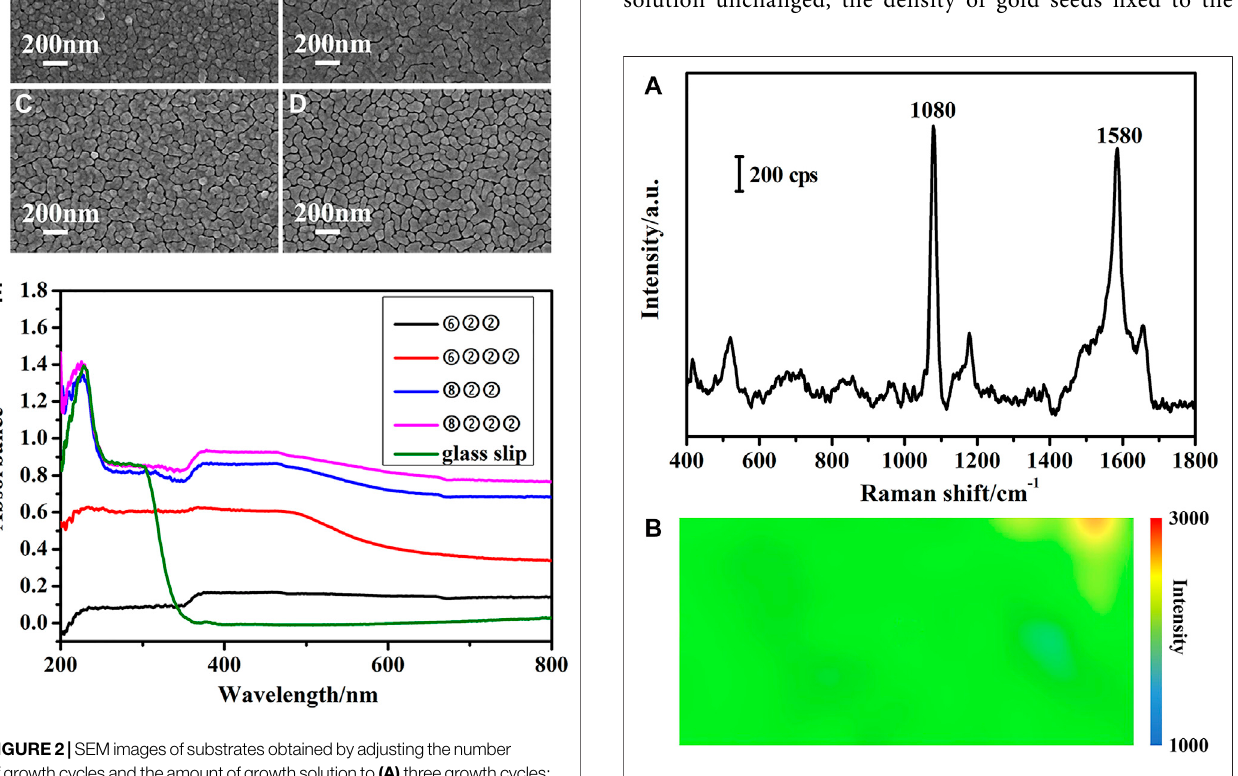
FIGURE3|(A) SERSspectrumof4-MBAand (B) SERSmappingimage of the optimized substrate based on the SERS intensity of the 1,080 cm − 1 peak of